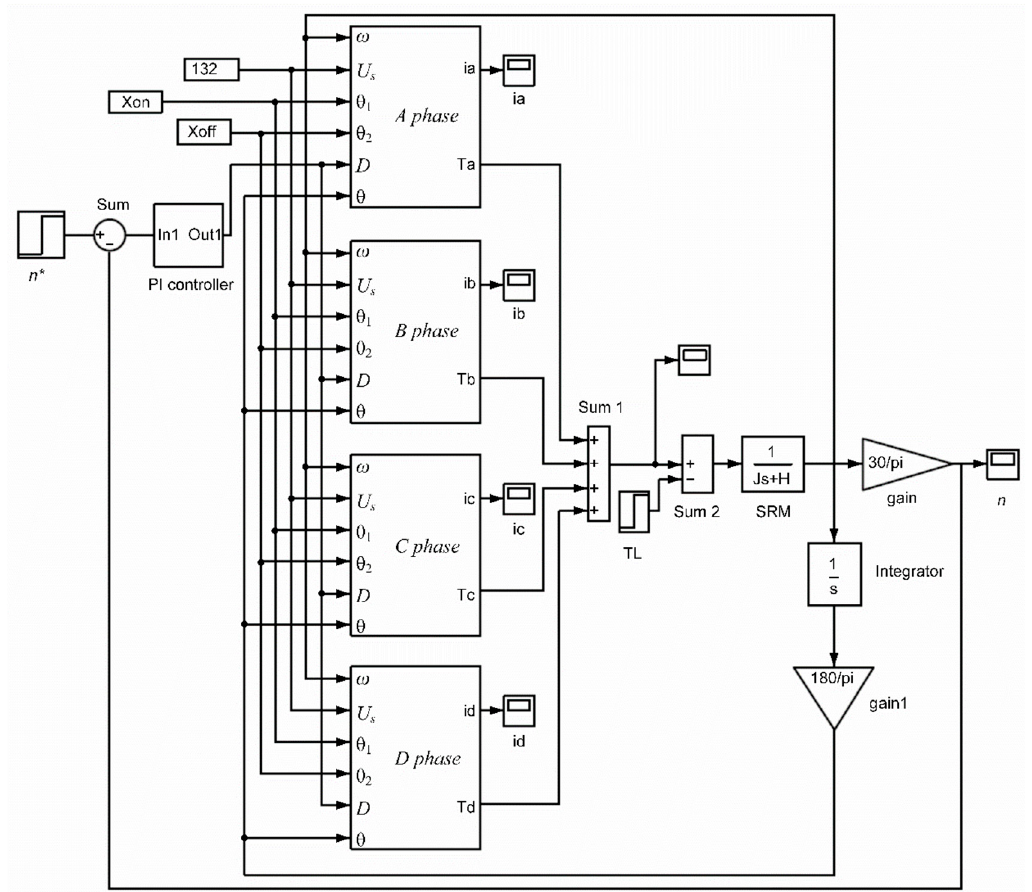
Figure 4. Nonlinear simulation main model of the switched reluctance motor drive.